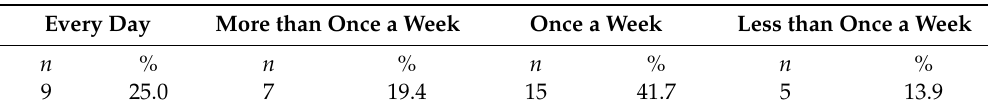
Table 2. Disinfection frequency of the independent water bottle reservoirs in 36 dental o ffi ces equipped among 153 studied in Eastern France in